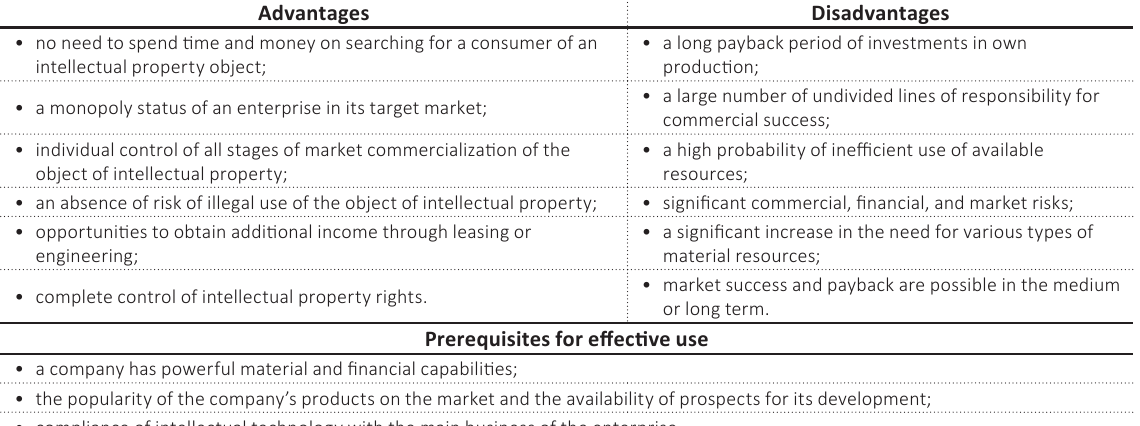
Table 1. Economic prerequisites for using vertical commercialization of intellectual property